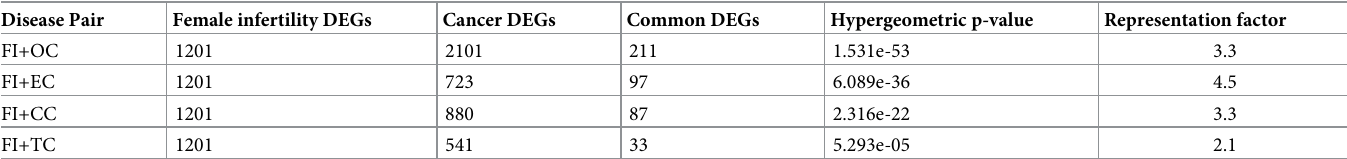
Table 2. Validation of DEGs by hypergeometric test. Disease